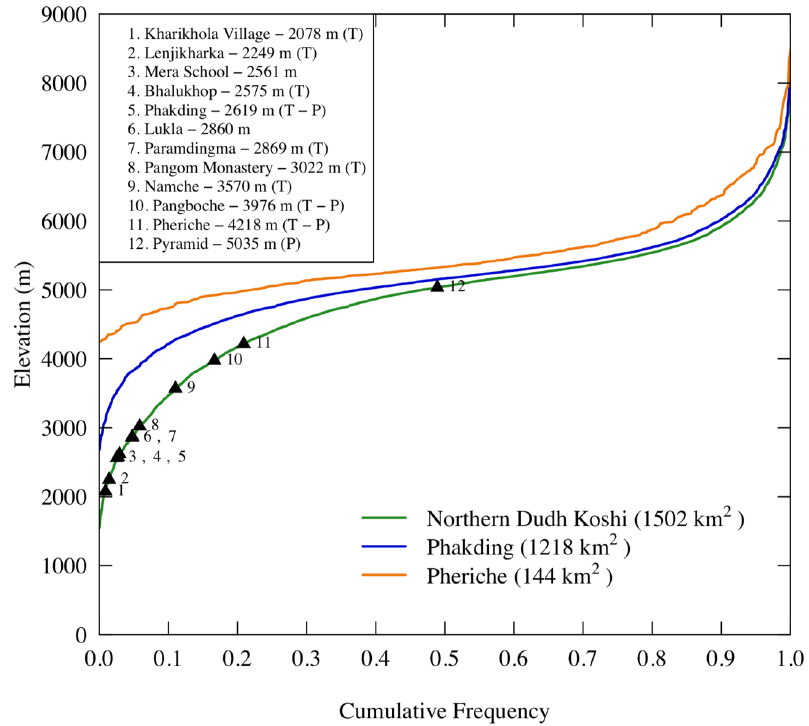
Figure 2. Hypsometric curve of Phakding, Pheriche, and the northern part of the Dudh Koshi River basin and the elevation of the meteorological stations. Source: SRTM (Shuttle Radar Topography Mission) digital elevation map [36].